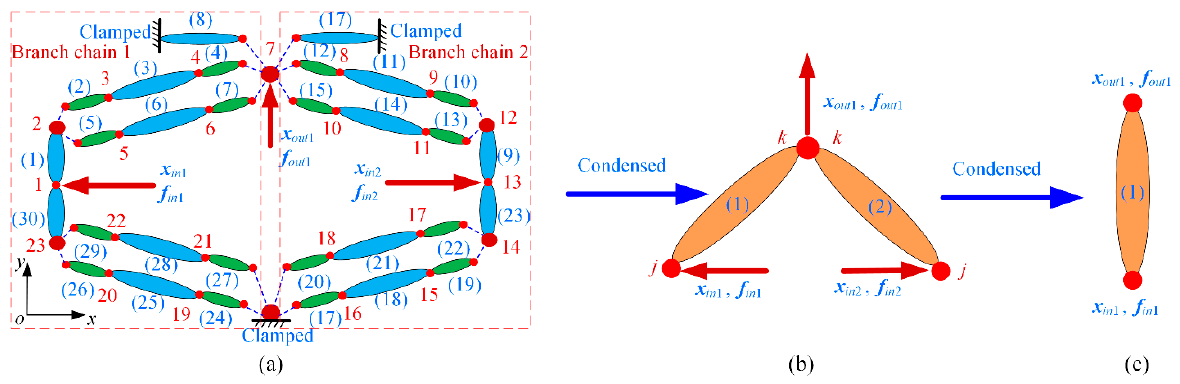
Figure 9. Condensed topology of the compliant amplifier: ( a ) numbering and discretization; ( b ) the equivalent topology; ( c ) the equivalent beam element.